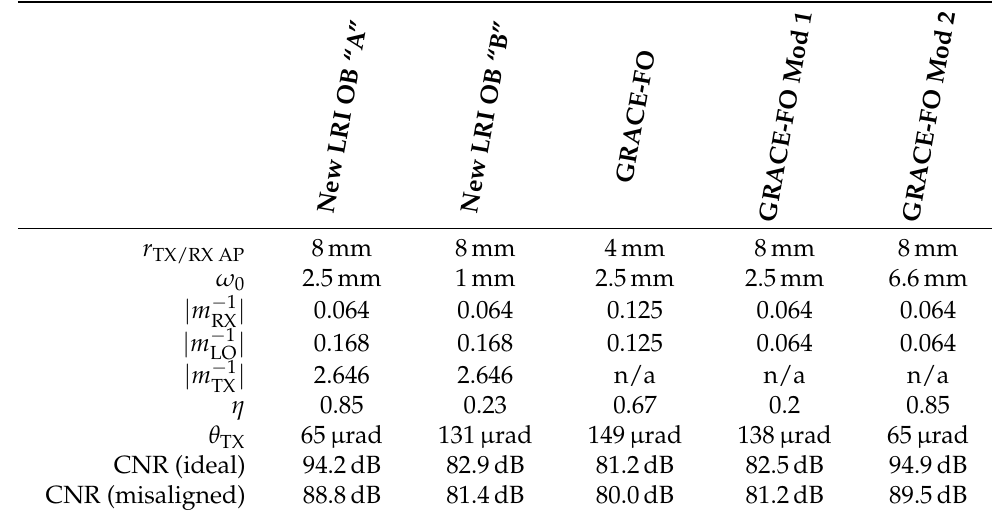
Table 1. Comparison of some optical parameters between two configurations of the proposed LRI OB design, the GRACE-FO LRI OB, and two modified versions of the GRACE-FO LRI OB. r TX/RX AP is the receive/transmit aperture; ω 0 is the waist radius of the local oscillator beam after the fiber injector; m − 1 with i = { RX, LO, TX } are the linear magnifications of the RX, LO, and TX imaging i systems, respectively; η is the heterodyne efficiency of the RX-LO beatnote; θ TX is the half-angle divergence of the TX beam out of the aperture; CNR (ideal) is the resulting carrier-to-noise density for perfectly aligned local and remote satellites; CNR (misaligned) is the resulting carrier-to-noise density considering a 50 µ rad misalignment of the local S/C with respect to the line-of-sight to the remote S/C